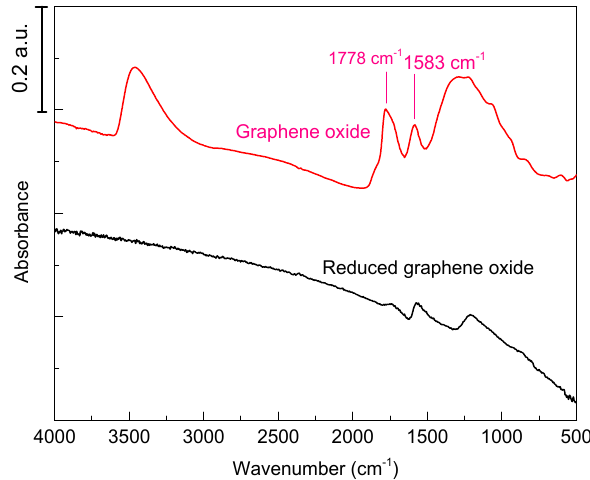
Figure 1. FTIR spectra of graphene oxide (GO) and reduced graphene oxide (reGO) vacuum treated at 150 °C for 2 h.